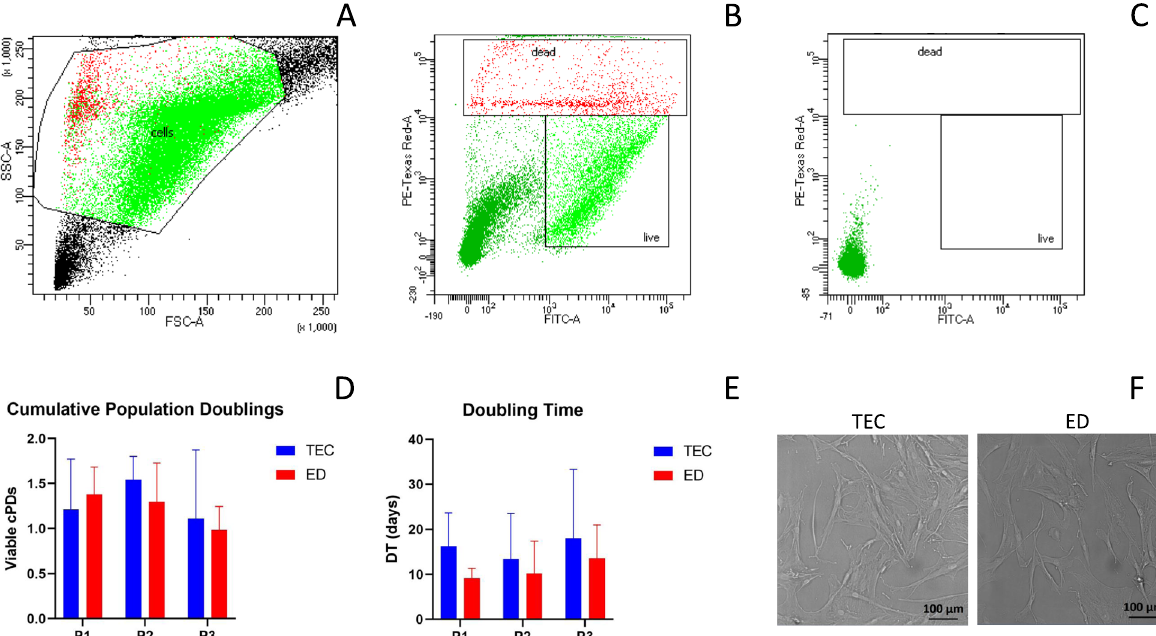
Fig. 1 Viability and cell culture. Flow cytometry data of a LIVE/DEAD ® Viability/Cytotoxicity Kit for mammalian cells. ( A ) Gating of stem cells based on side scatter (SSC-A) and forward scatter (FSC-A) to exclude debris and leucocytes, and ( B ) Sample staining showing gating on live and dead cells based on green and red fluorescence following isolation with enzymatic digestion (ED) immediately after thawing. ( C ) Unstained control showing no false positive on the flow cytometry viability assay. Box plot showing ( D ) viable cumulative population doublings (cPDs) and ( E ) doubling time (DT) (in days) of stem cells at passage (P) 1 to 3 from cryopreserved microfragmented adipose tissue (AT) ( n culture (TEC) and ED, respectively. Error bars indicate standard deviation. ( F ) Representative brightfield images at 20 monolayer cells at passage 4 when isolated with TEC and ED, respectively, and cultured in normal expansion